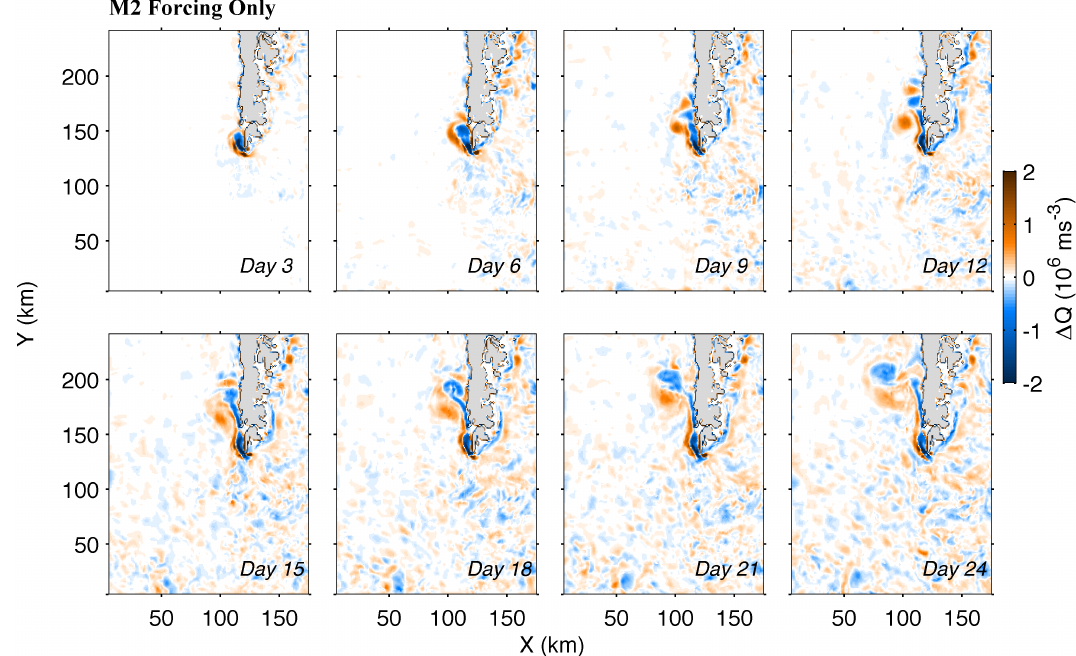
Fig. 8. Results of a model run the same as the base run, but with just M 2 tidal forcing.